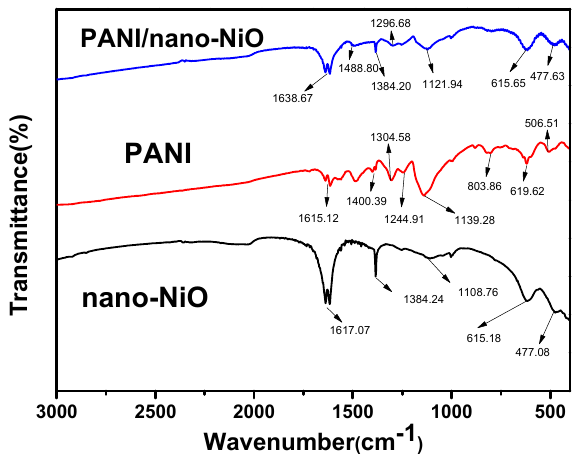
Figure 3. FTIR spectra of nano-NiO, PANI and PANI/nano-NiO.